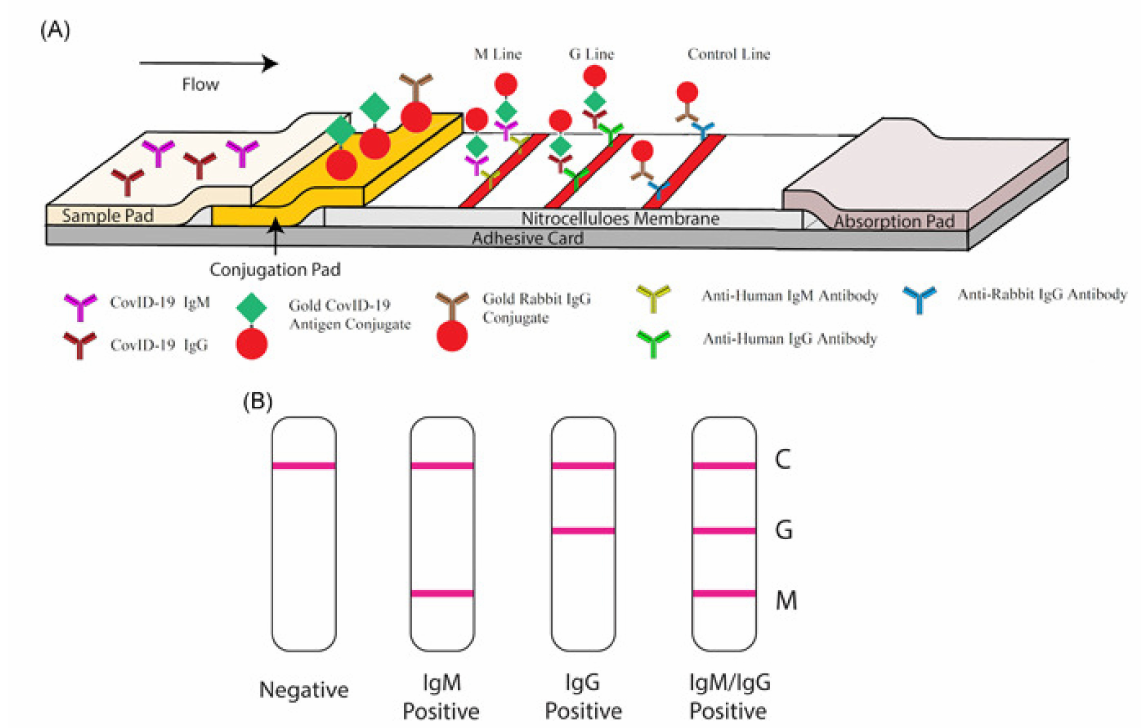
Figure 2. Schematic illustration of rapid SARS-CoV-2 IgM-IgG combined antibody test. ( A ), Sche- matic diagram of the detection device; ( B ), an illustration of different testing results, where C means control line; G means IgG line; M means IgM line. IgG means immunoglobulin G; IgM means im-munoglobulin M; SARS-CoV-2 means severe acute respiratory syndrome coronavirus 2. Adapted with permission from Ref. [90]. Copyright 2020, Wiley Periodicals,